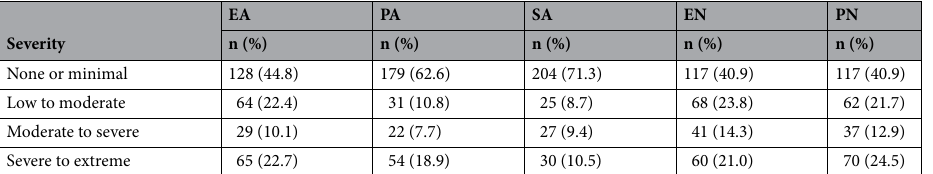
Table 3. Severity level of CTQ abuse and neglect subscales stratified by frequency and percent of sample scoring in each respective severity range (n = 286). Category value ranges are defined following Bernstein 43 . EA CTQ emotional abuse, PA CTQ physical abuse, SA CTQ sexual abuse, EN CTQ emotional neglect, PN CTQ physical